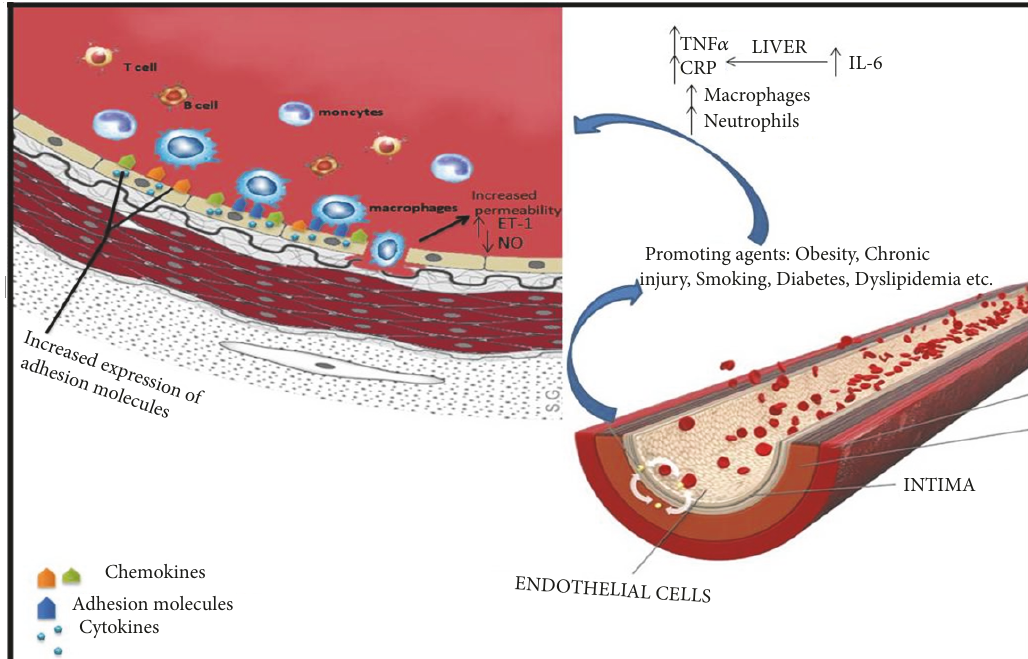
Figure 1: Etiology of the inflammatoryprocess. Low levelchronicinflammation increasesthe concentrationsof markers and of inflammatory cells, leading to increased production of C-reactiveprotein (CRP) by the liver, in response to interleukin-6(IL-6), whichprovokes a reduction in vasodilation and an increase in vascular damage. TNF-a: tumor necrosis factor alpha; IL-6: interleukin-6; CRP: C-reactive protein; NO: nitric oxide; ET-1: